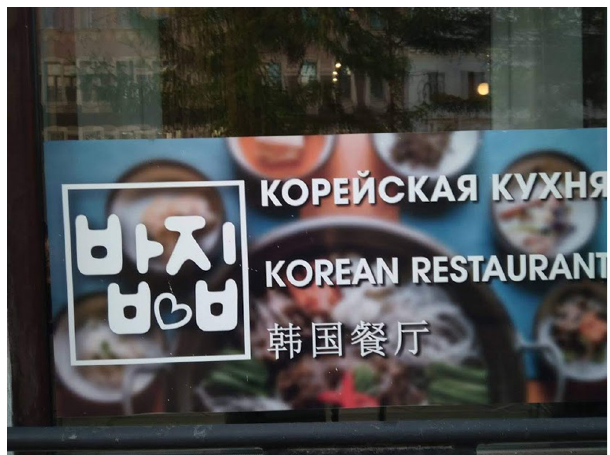
Figure 3: Signboard of Korean restaurant Bab Jib . Sixth line of Vasilievsky island, St. Petersburg, 2019, LinguaSnapp SPb.